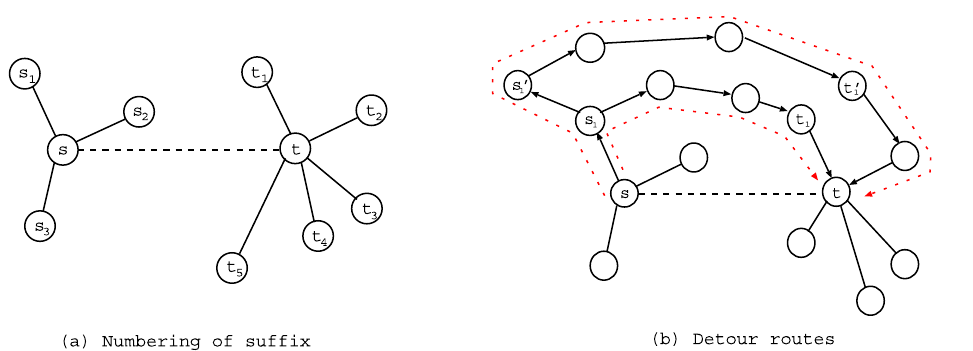
Figure 2. Basic process in the mapping to directed acyclic graphs from a planar network. ( a ) Parts of the connecting nearest-neighbors of s and t . Solid lines are connection edges. Dashed line represents the virtual s - t line segment. ( b ) Red dotted lines represent detour routes. s ′ 1 and t ′ 1 are the next-nearest neighbors of s and t